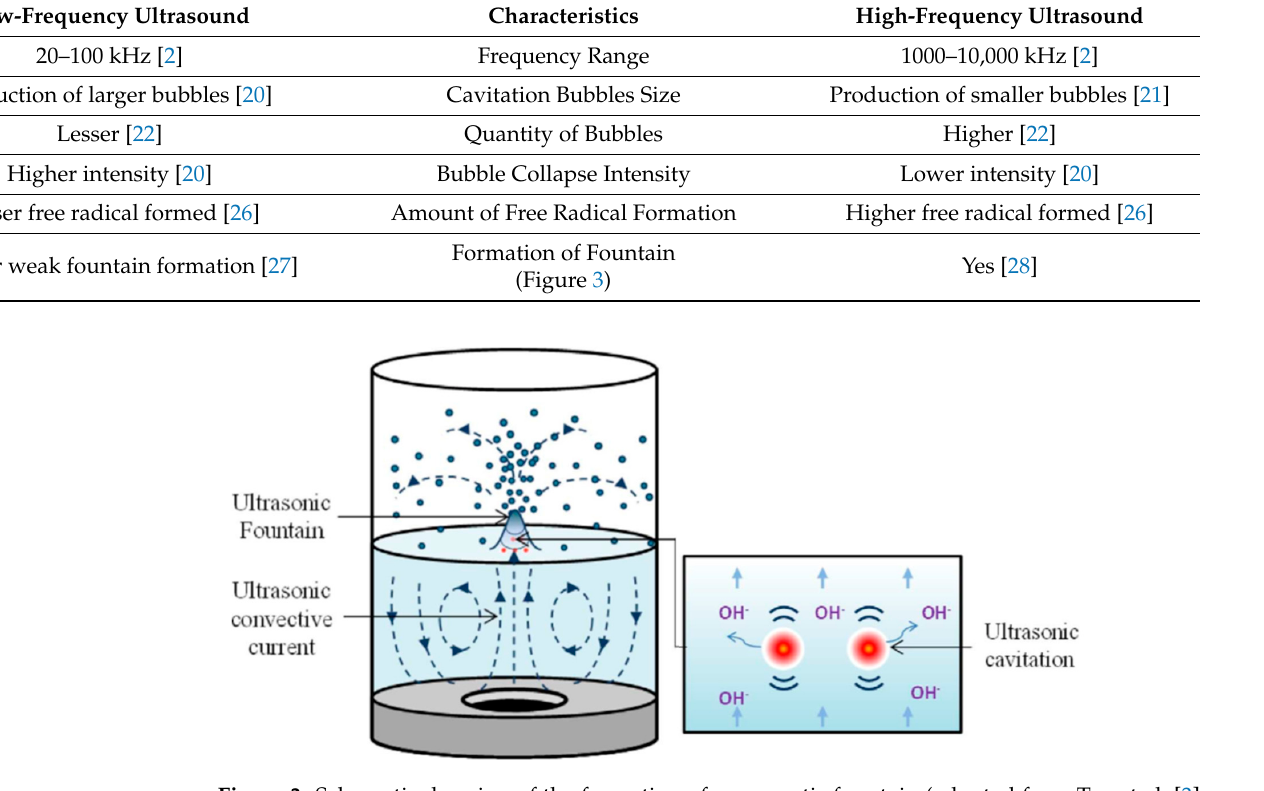
Figure 3. Schematic drawing of the formation of an acoustic fountain (adapted from Tay et al. [3] with permission from the publisher).